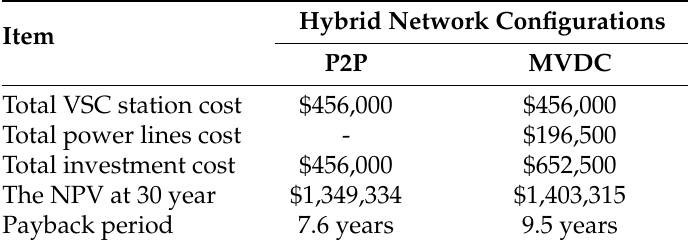
Table 5. An estimated investment cost and return on